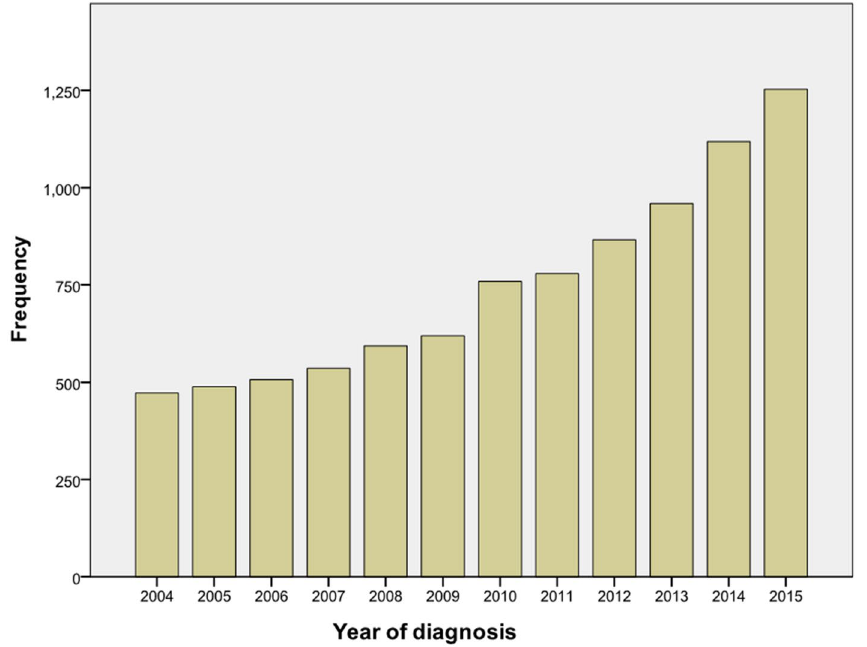
Figure 1. Frequency map of intrahepatic cholangiocarcinoma in SEER database from 2004 to 2015.